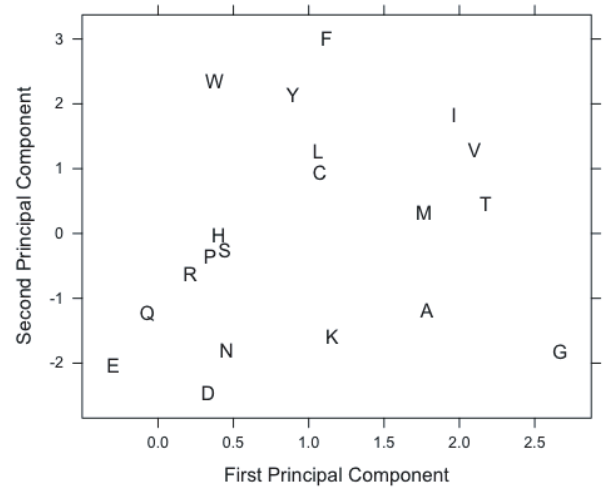
Figure 4. A learned amino acid embedding. The figure shows an approximation of a 15-dimensional embedding of amino acids, learned by a neural network trained on the natural protein task. The projection to 2D is accomplished via principal component